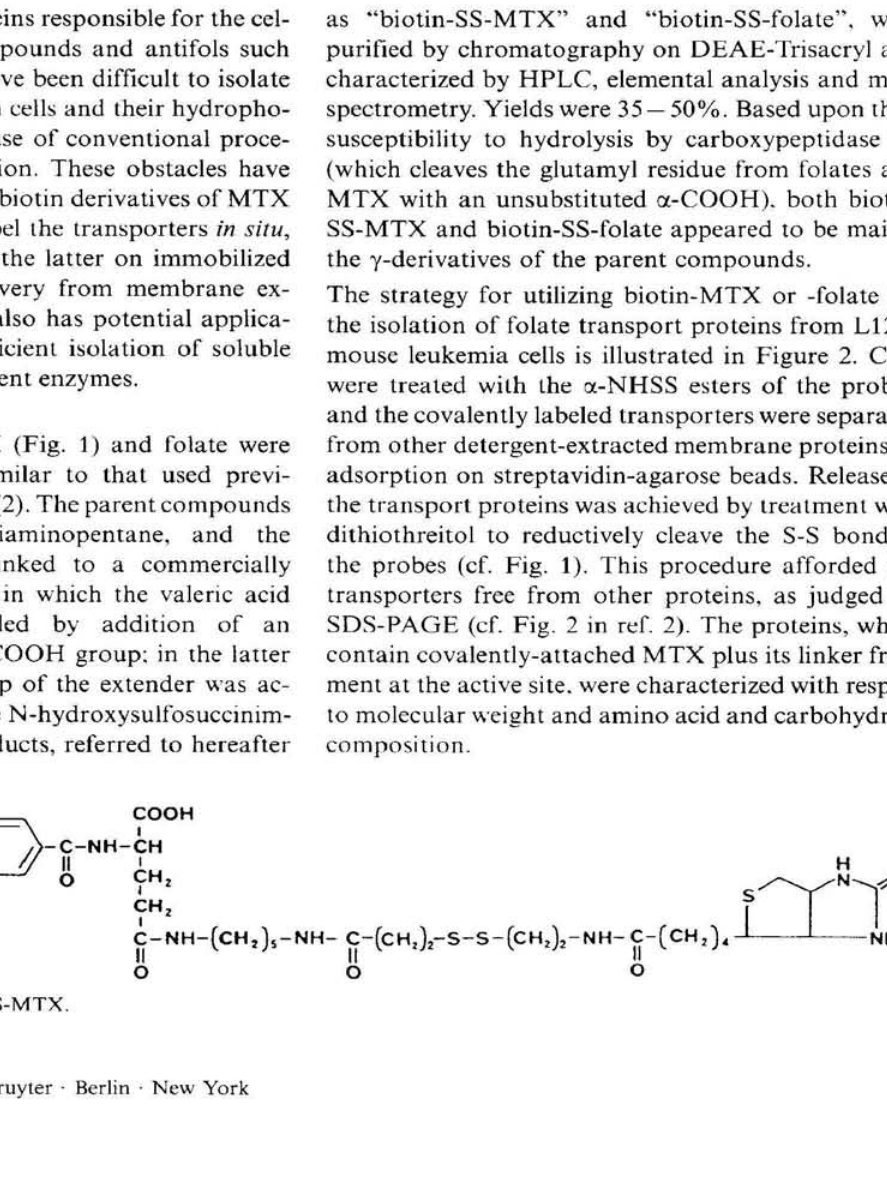
Figure 1. Structure of